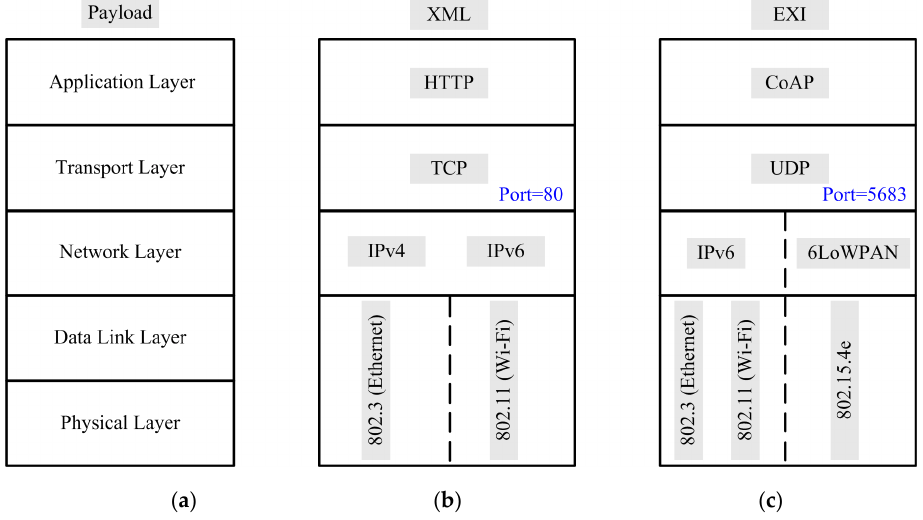
Figure 4. Communication protocols in the IEEE model ( a ); the HTTP ( b ); the CoAP ( c ).